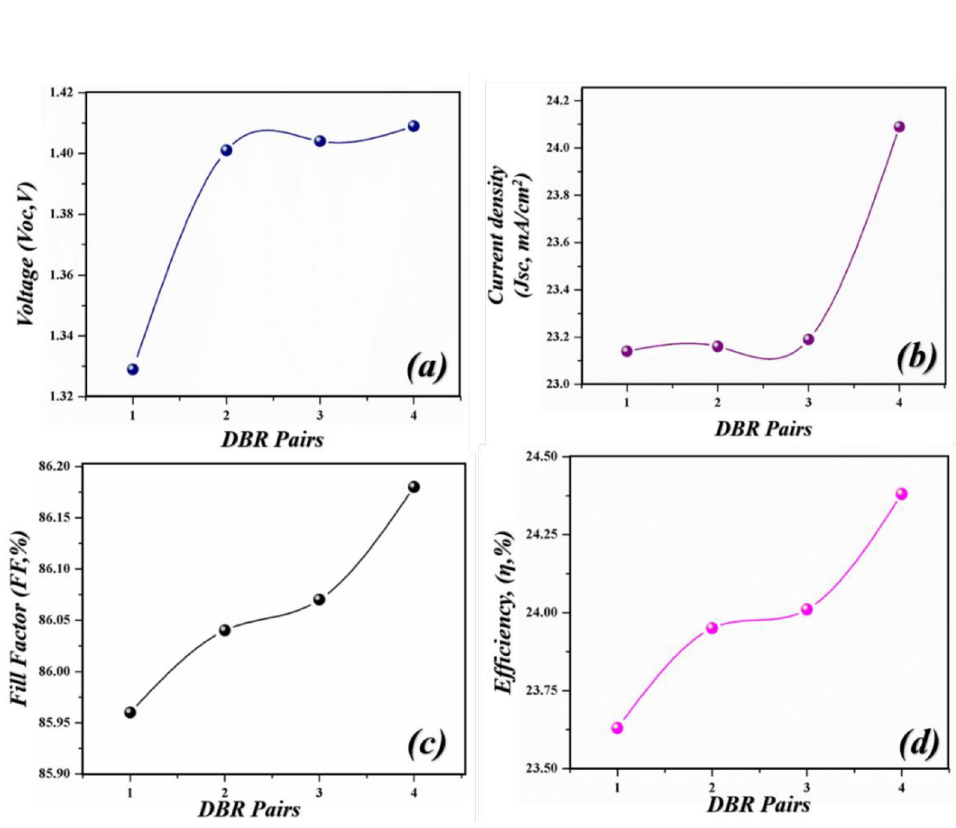
Fig 5. Simulated photovoltaic parameters of novel geometry with different DBR pairs (si/SnO 2 ) (a) V oc as an as an independent function of a light-harvesting layer (c) FF as an independent function of light-harvesting layer, (b) J sc independent function of light-harvesting layer (d) PCE as an independent function of light-harvesting layer.